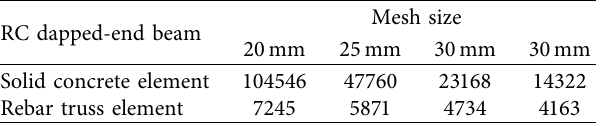
Table 4: Mesh data for diferent meshes considered for mesh sensitivity analysis.